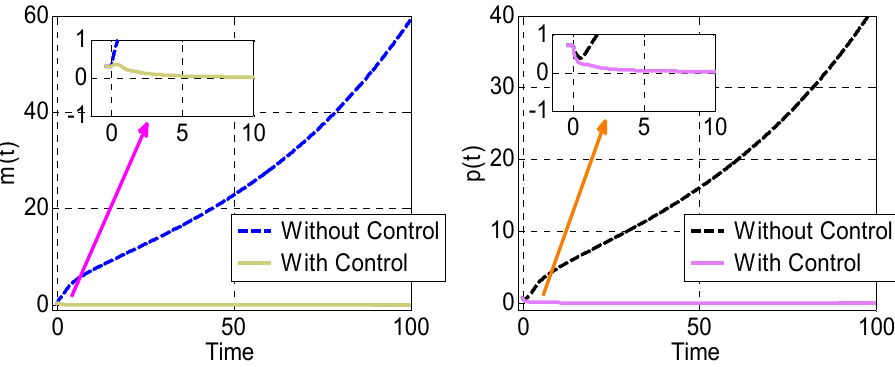
Figure 4. Contrasting time response of the two-dimension FOGRN when α = 0.8.